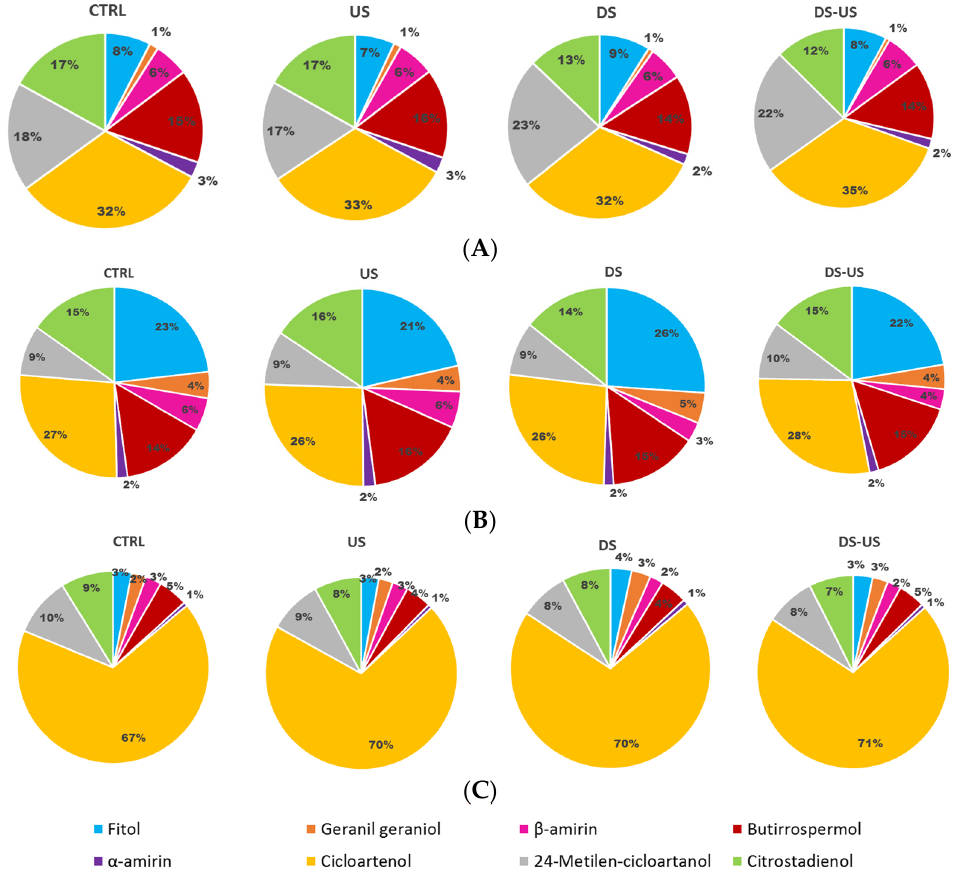
Figure 5. Total triterpene alcohols (mg/kg) of Peranzana ( A ), Canino ( B ), and Coratina ( C ) EVOOs, treated by the different processes (CTRL = control test, US = ultrasound test, DS = destoned test, DS-US = destoned-ultrasound test).